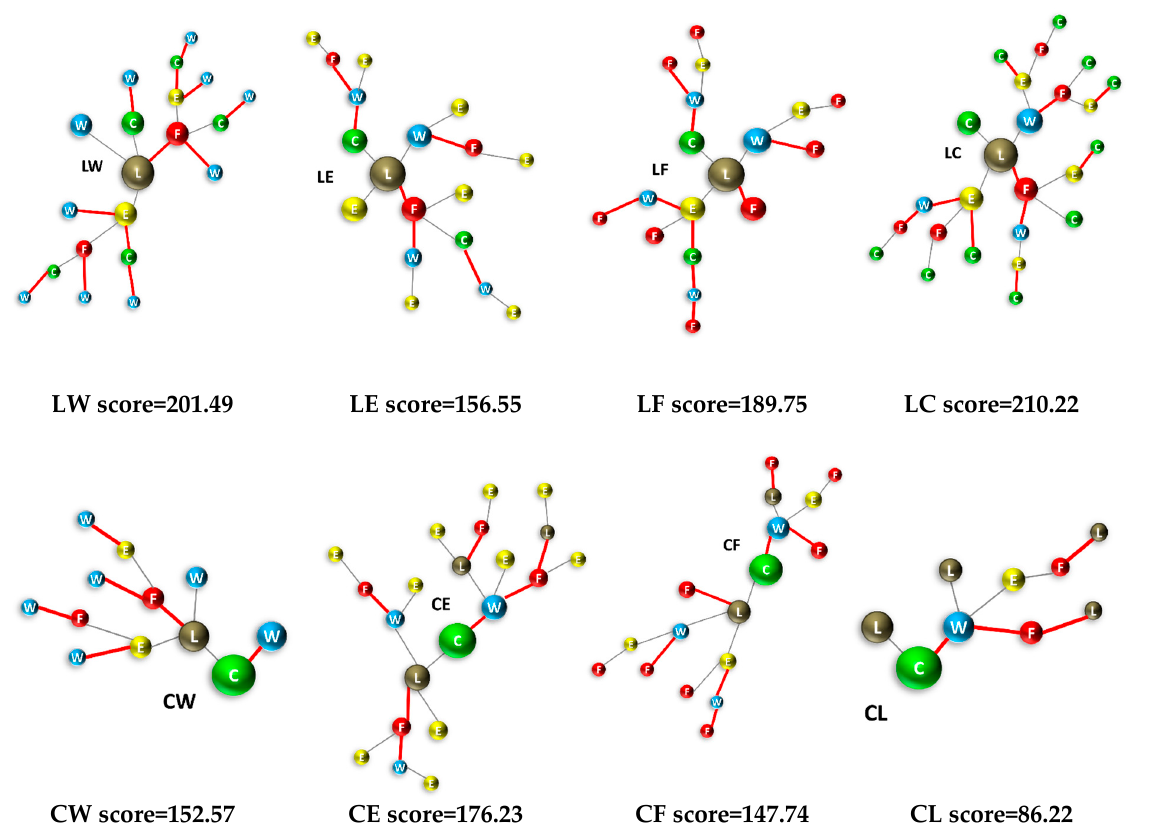
Figure 5. Nexus trees for all interlinkages among all five nexus elements, showing the extent of interactions for the 20 nexus interlinkages. Red lines represent “strong” interlinkages, while black lines represent “weak” interlinkages. Total interlinkage scores are written under each tree. Color representation for nexus tree nodes are as follows: Water = blue; Energy = yellow; Food = red; Land = brown; Climate = green.